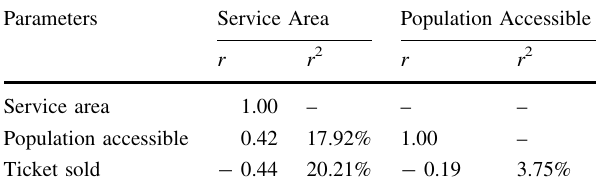
Fig. 7 Service areas of stations a Coca Cola, b Bambis Table 6 Showing correlation coefficients (r) and coefficient of determination ( r 2 ) for 400-m walking distance Parameters